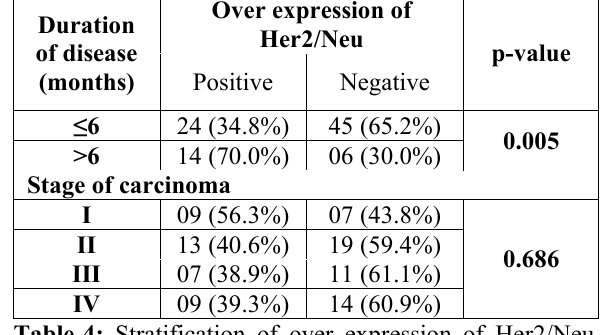
Fig-2: Frequency of overexpression of Her2/Neu in urothelial carcinoma of bladder (n=89) The over-expression of Her2/Neu is based on sickness duration. Over expression of Her2/Neu dependent on tumor stage is shown in Table-4.